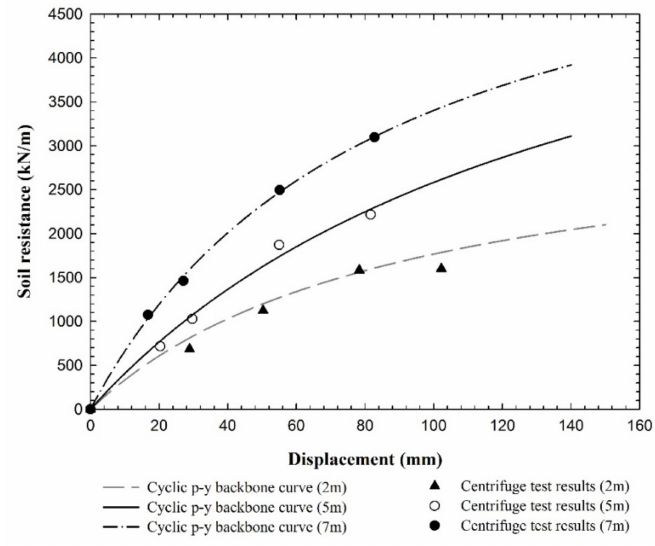
Figure 12. Cyclic p–y backbone curve at N cycle = 100.